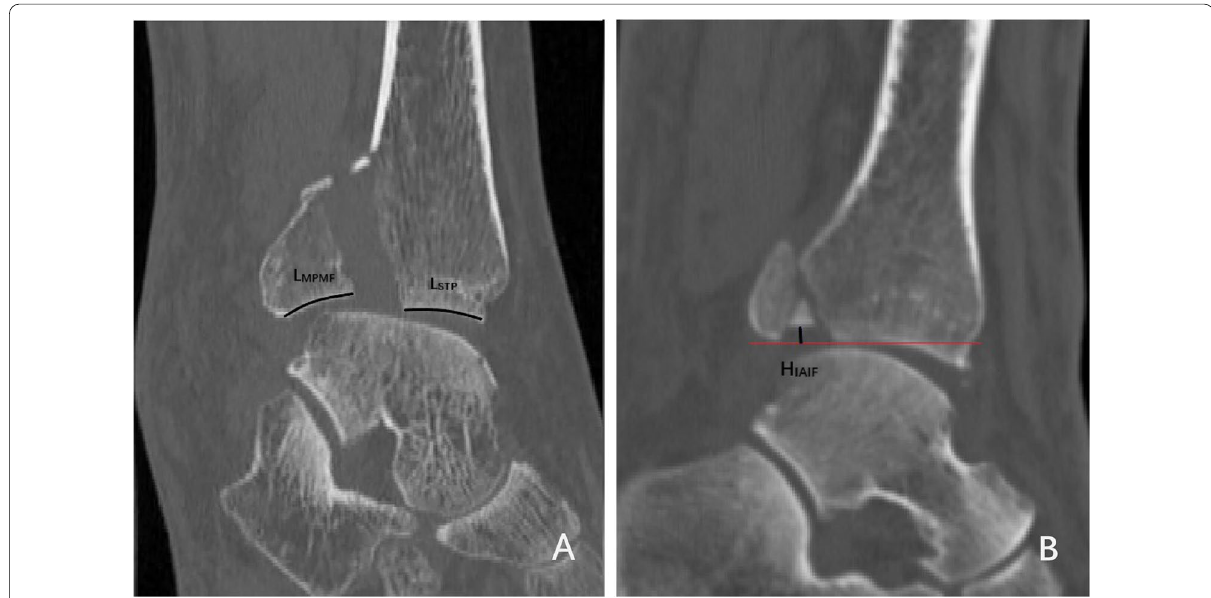
Fig. 2 Example sagittal CT linear measurements. A Measured as the length of major posterior malleolar fragment ( L MPMF , length of major posterior malleolar fragment) and stable tibial plafond ( L